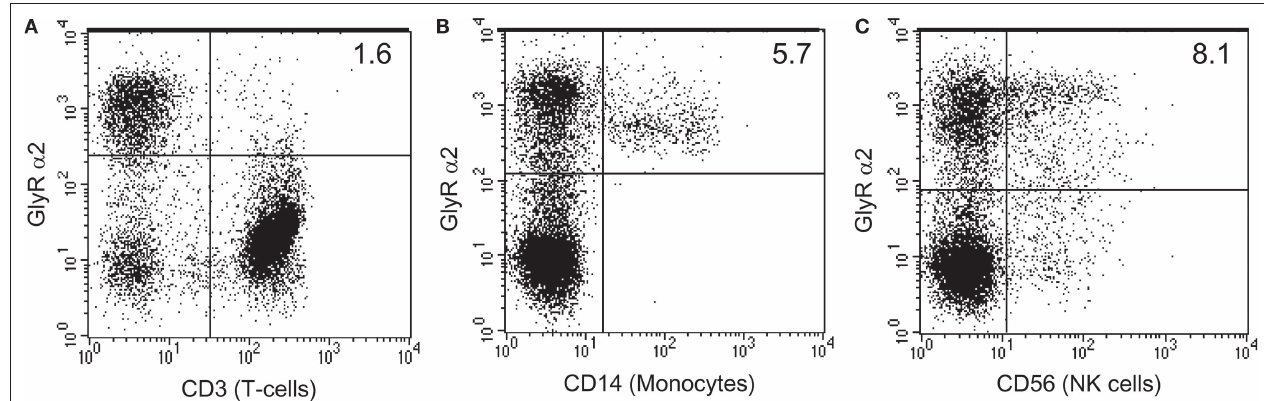
FIGURE 2 | Human monocytes and NK cells express GlyR α 2 subunits. Human peripheral blood mononuclear cell subsets were evaluated for the expression of GlyR α 2 using a rabbit anti human GlyR α 2 antibody (FITC) and either mouse anti-human CD3 (APC), mouse anti-human CD14 (PE) or mouse anti-human CD56 (PE) (BD Pharmingen). Cells were stained according to the manufacturers protocols. GlyR α 2 positive cells make up 30% of the total PBMC population. The T cell population (CD3 + ) accounts for more than 60% of